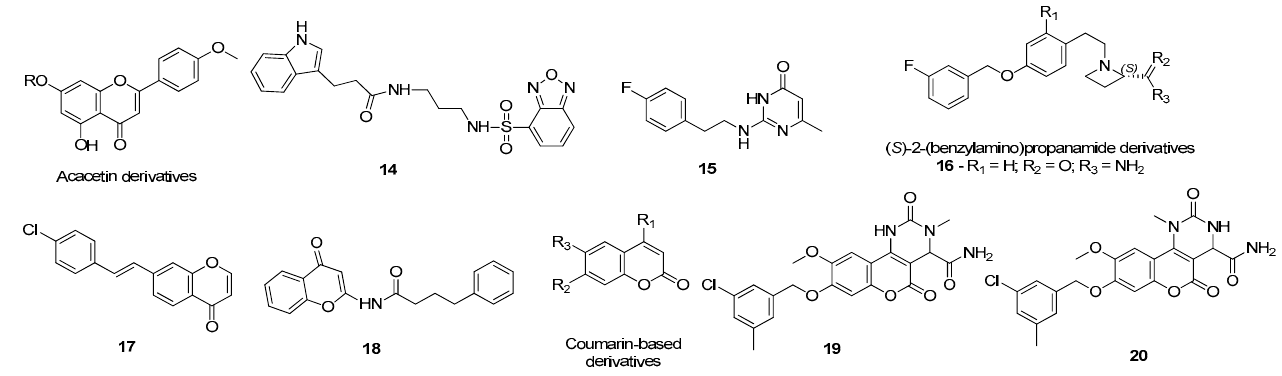
Figure 16. Structures of the studied MAO-B inhibitors.